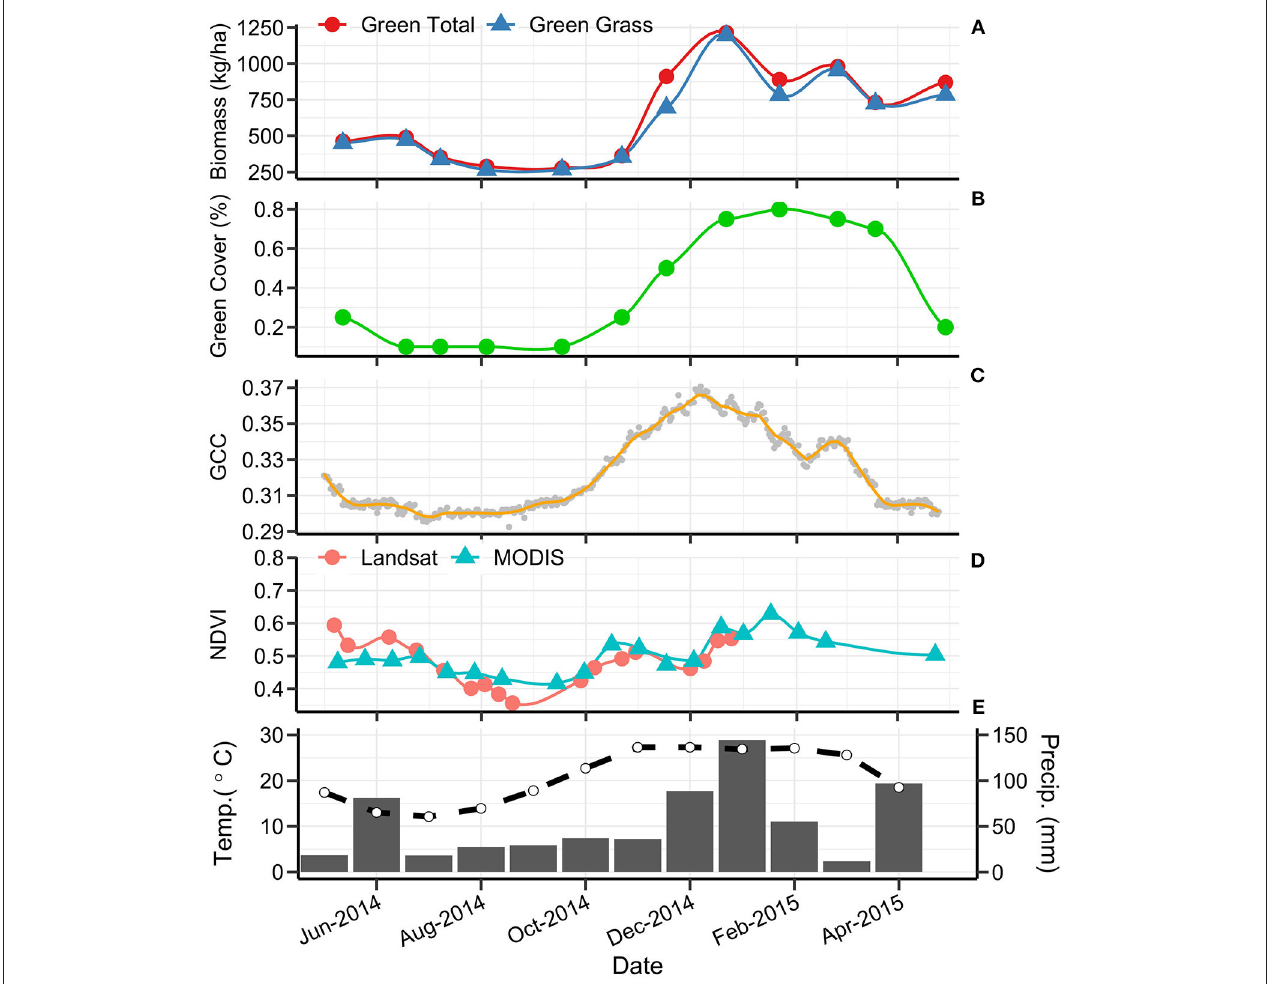
FIGURE 8 | Multi-scale phenology from 1 May 2014 to 30 April 2015 at site GIDL (C 4 Native). From top to bottom panel: (A) total green biomass (•) and green grass biomass ( N ) in kg/ha; (B) green cover (%); (C) phenocam 13:00 daily g CC ; (D) Terra MODIS ( N ) and Landsat OLI/ETM + (•) NDVI; (E) monthly mean maximum temperature ( ◦ C; dashed line; Tuggeranong Bureau of Meteorology station) and the monthly rainfall (mm; solid bars; Australian National Botanic Gardens Bureau of Meteorology